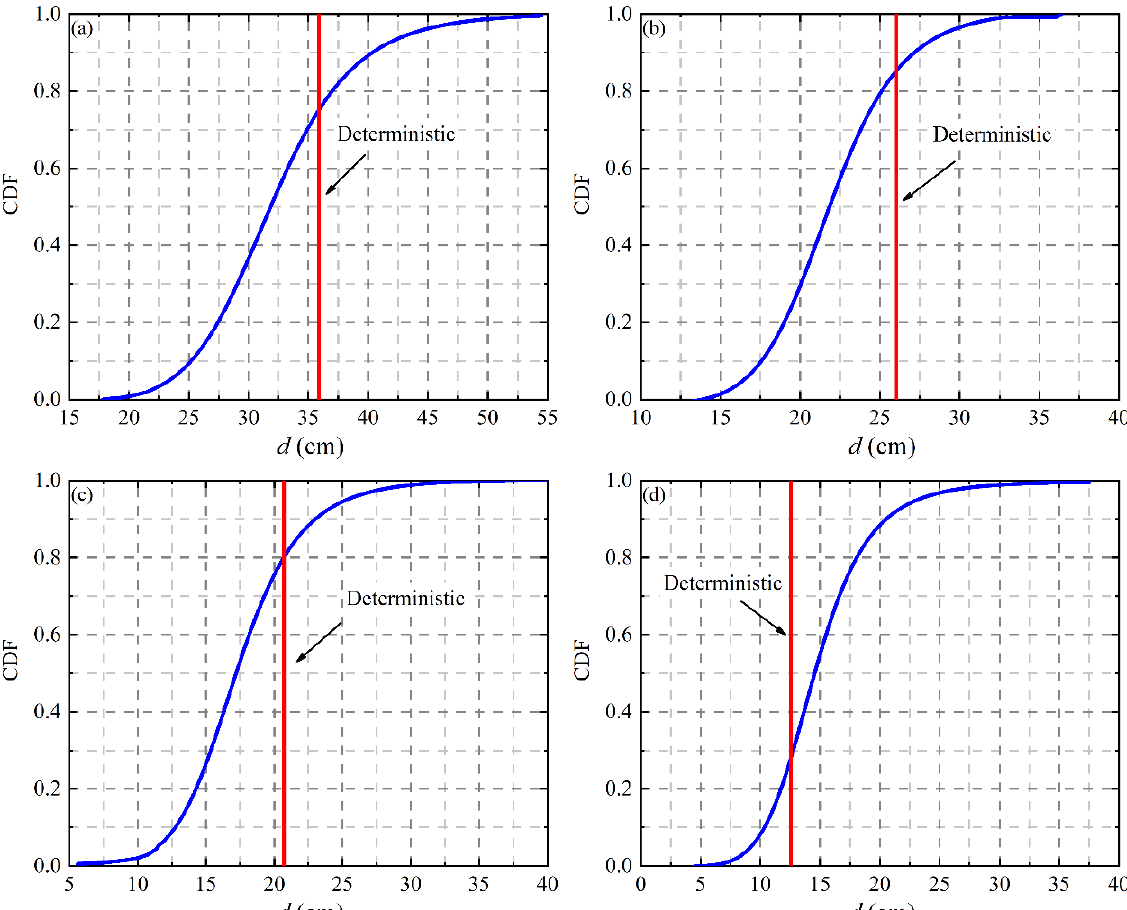
Figure 19. CDF of the peak value of vertical surface displacement at different embedment depths: ( a ) H = 6 m; ( b ) H = 8 m; ( c ) H = 10 m; ( d ) H = 12 m.